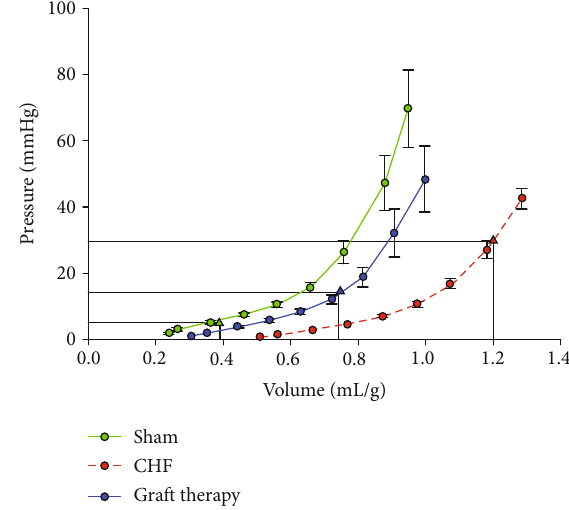
Figure 2: Rat diastolic pressure-volume relationship. Ex vivo pressure-volume ( P / V ) diastolic fi lling curves of sham ( n = 4 ), CHF ( n = 5 ), and graft-treated rats ( n = 7 ). Left ventricular volumes were normalized to each rat ’ s body weight. CHF results in a rightward shift in P / V fi lling curve and an increase in the operating volume. The graft-treated rats have a P / V fi lling curve shifted back towards sham and a lower operating volume, consistent with reversal of maladaptive remodeling related to